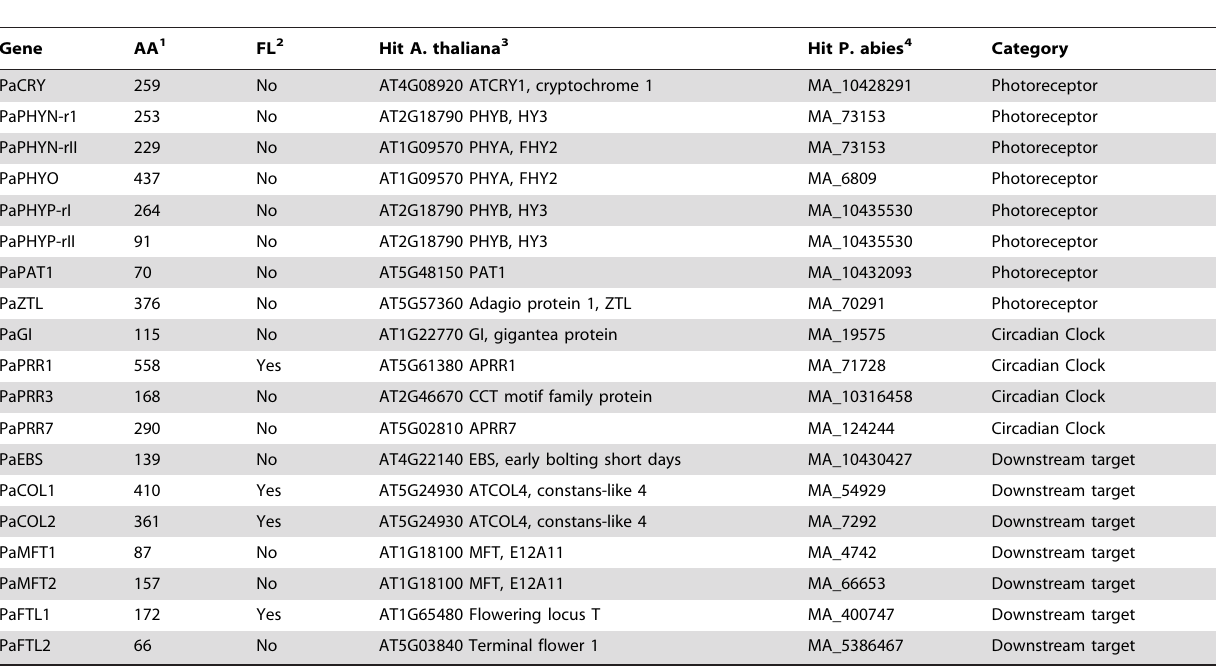
Table 1. Annotation of putative photoperiod pathway genes from spruce when compared to the proteins of the model plant Arabidopsis and accession number for the best hit in the current version of the P. abies genome